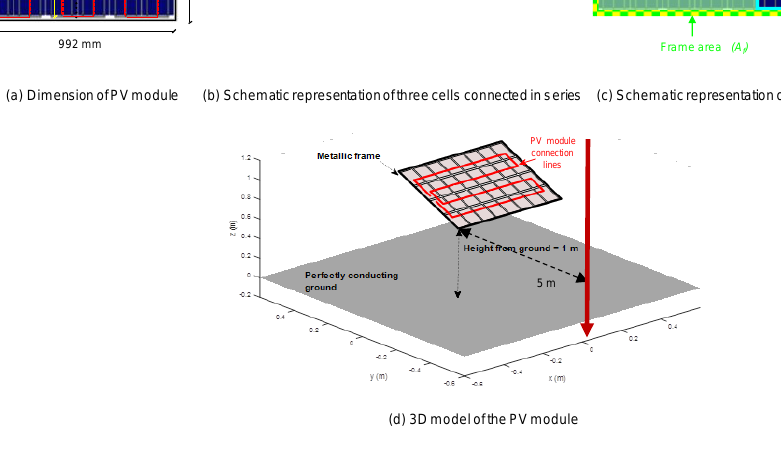
Figure 5. 270 Wp-PV module investigated.